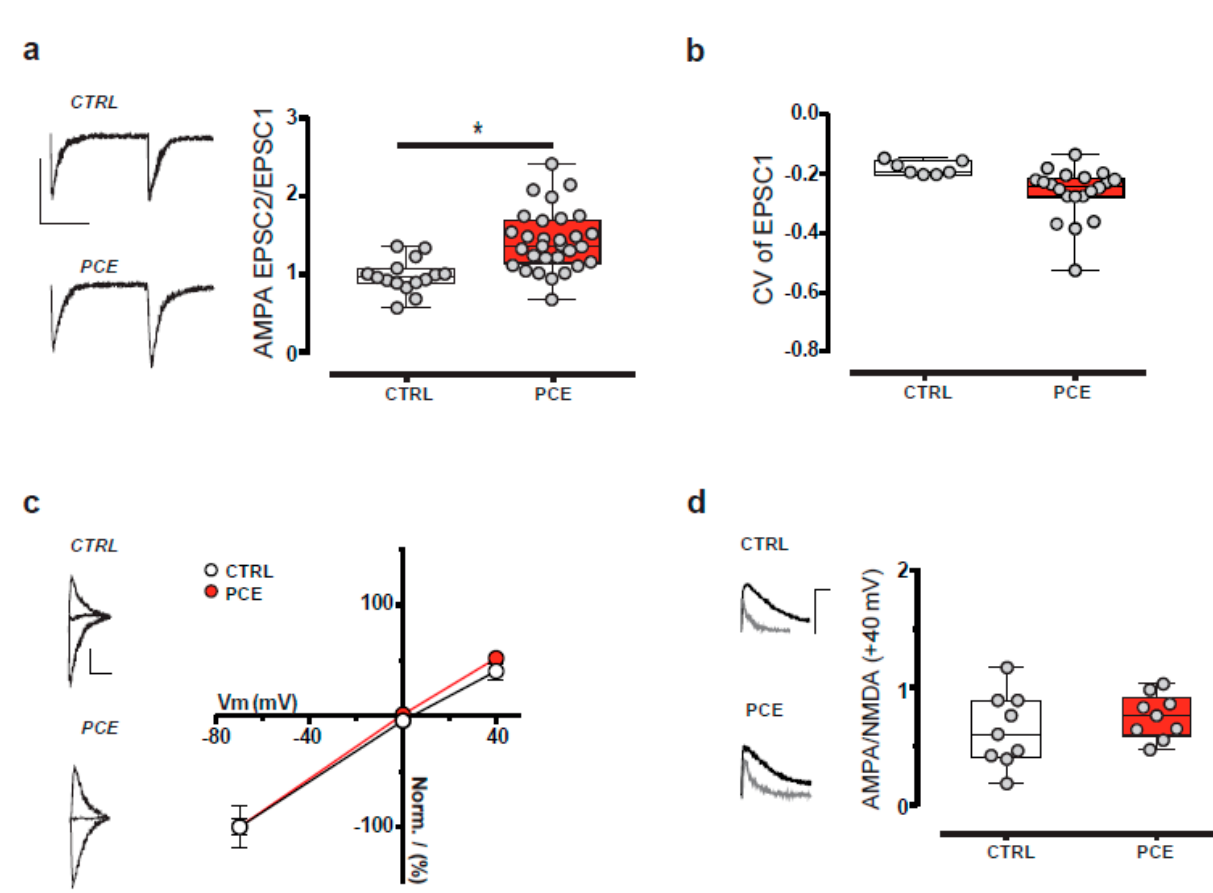
Figure 6. Excitatory synaptic properties of putative VTA dopamine neurons are not changed by PCE in female preadolescent offspring. ( a ) Dopamine cells from PCE ( n cells : 30, n rats : 11/group) offspring exhibit an increased paired-pulse ratio (EPSC2/EPSC1) of AMPA EPSCs compared to CTRL (n cells : 15, n rats : 7/group) group. The left-hand panel shows representative traces of paired AMPA EPSCs recorded from VTA putative dopamine neurons of CTRL and PCE offspring. Calibration bar: 25 ms, 50 pA. ( b ) PCE effects on 1/CV2 values (PCE n cells : 20, CTRL n cells : 7). ( c ) Current–voltage relationship ( I – V ) curves of AMPA EPSCs recorded from dopamine neurons in PCE ( n cells : 10, n rats : 12/group) and CTRL (n cells : 8, n rats : 8/group) offspring. Data are represented as mean ± s.e.m. AMPA EPSCs traces recorded at − 70 mV, 0 mV, and +40 mV from CTRL and PCE rats are shown on the left. Calibration bar: 10 ms, 25 pA. ( d ) The AMPA/NMDA ratio is not affected by PCE. The left-hand panel shows representative traces of AMPA and NMDA EPSCs traces recorded from dopamine neurons held at +40 mV in slices from PCE ( n cells : 9, n rats : 9/group) and CTRL ( n cells : 9, n rats : 7/group) offspring. Calibration bar: 10 ms, 50 pA. Unless otherwise specified, all data are represented as box-and-whisker plots with single values (min to max). *, p < 0.05.